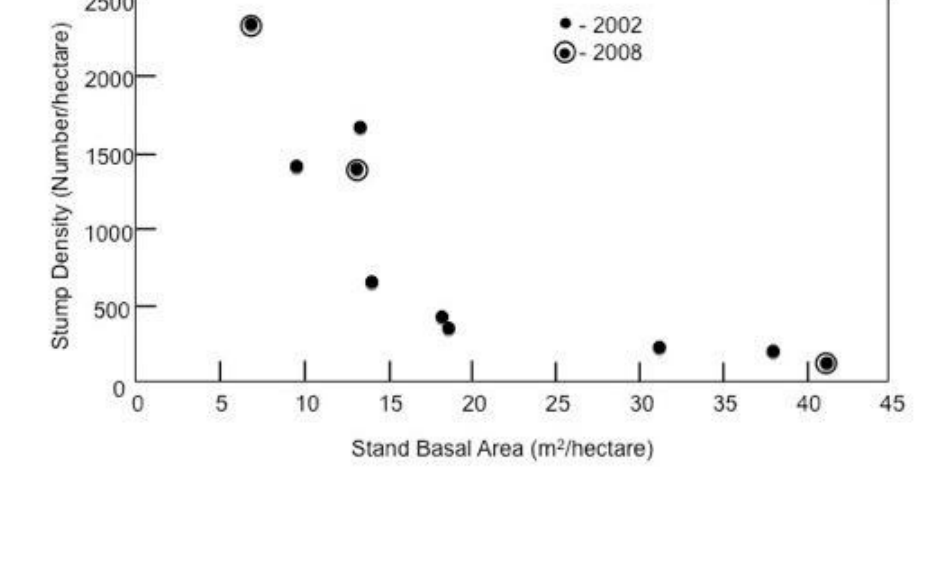
Fig. 5. Number of stumps per hectare plotted against basal area for 20 × 20 m² plots (2002) or 20 m diameter circular plots (2008). High numbers of stumps, reflecting heavy human use, are associated with low basal area per